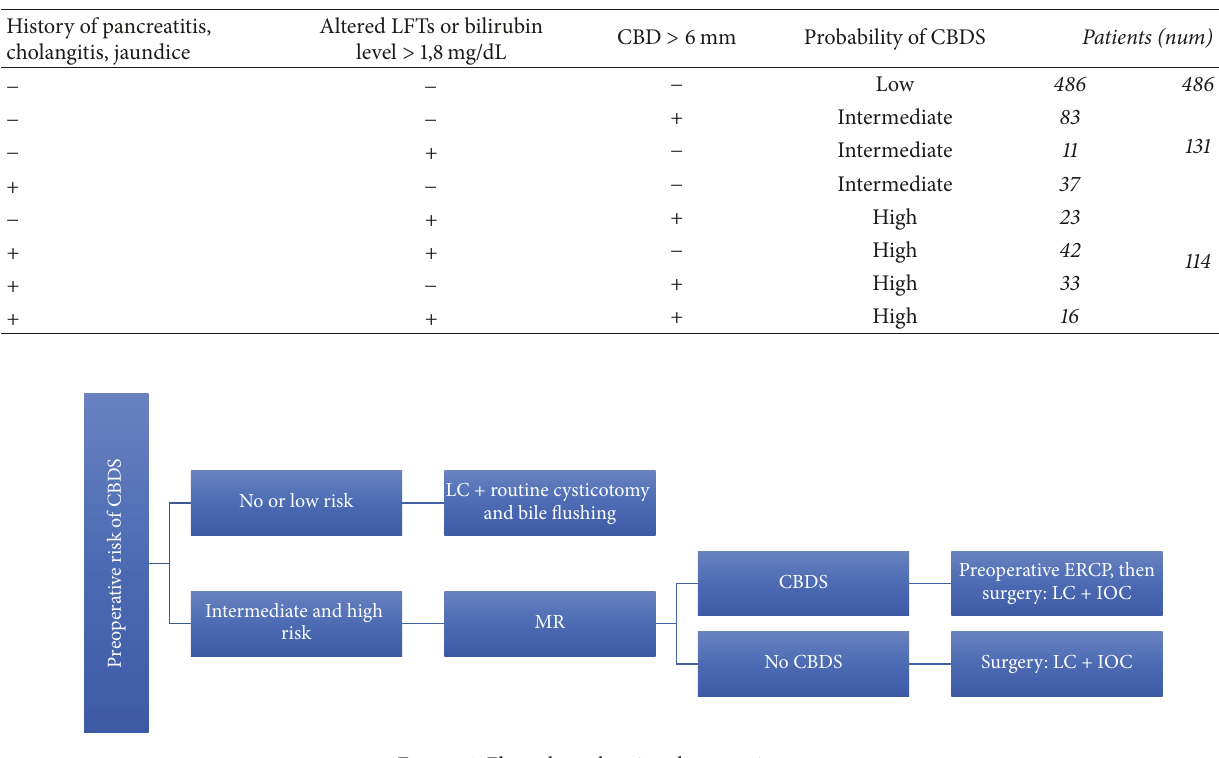
Table 1: Population studied, stratified by preoperative risk of CBDS.